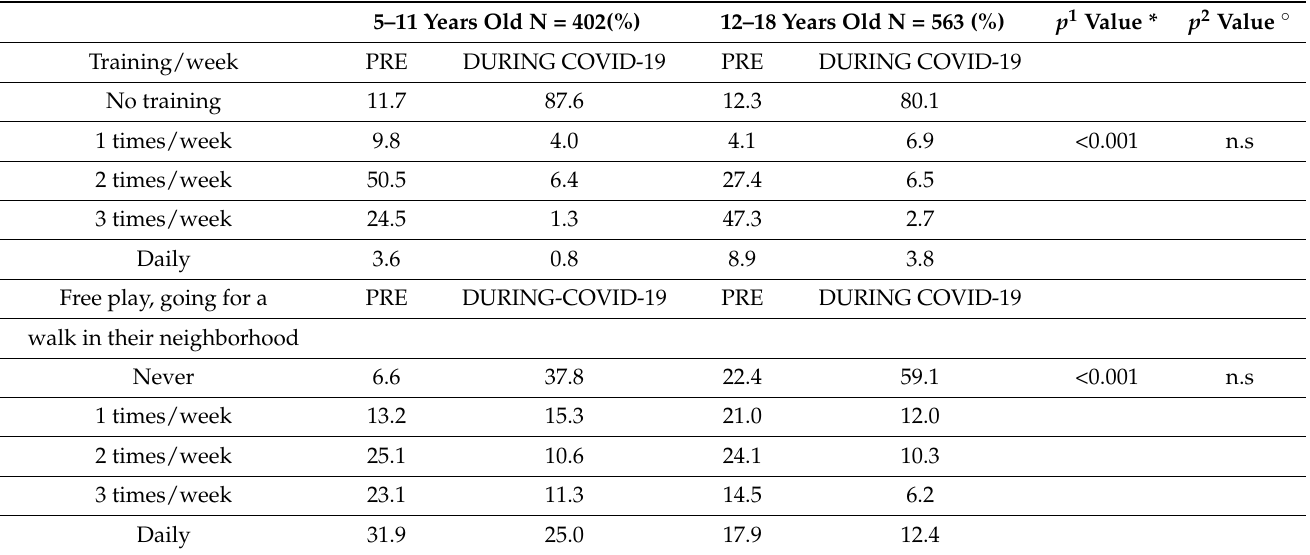
Table 3. Training before and during the COVID-19